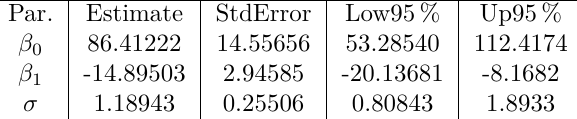
Table 6. Mean estimations for